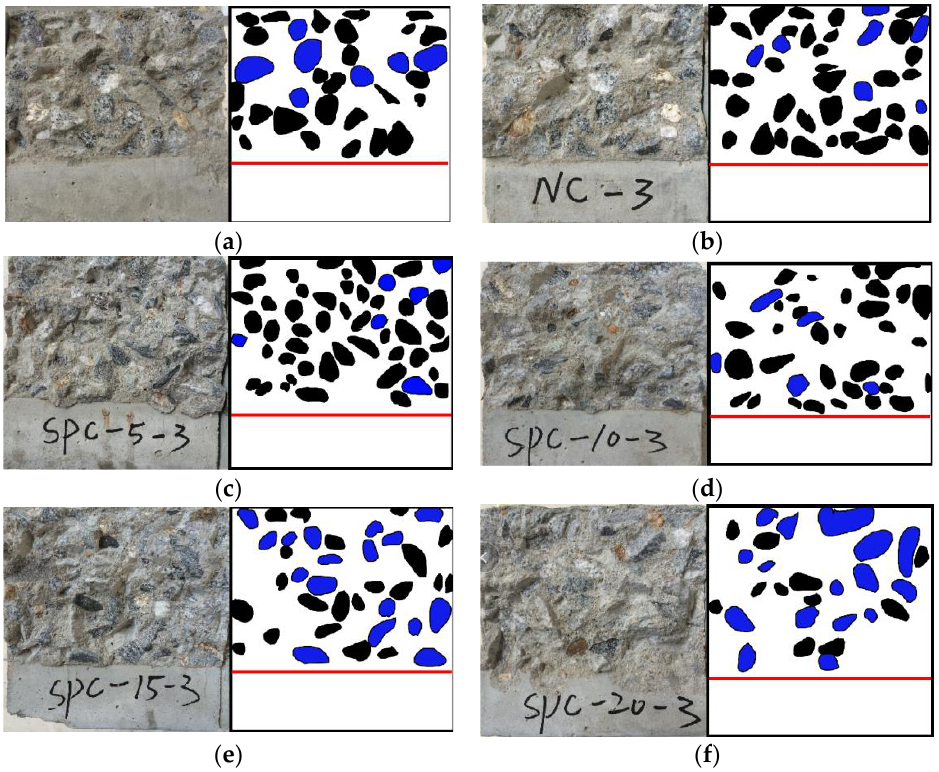
Figure 3. Fracture morphology of notched beam. ( a ) NC; ( b ) NC; ( c ) SPC5; ( d ) SPC10; ( e ) SPC15; ( f ) SPC20.